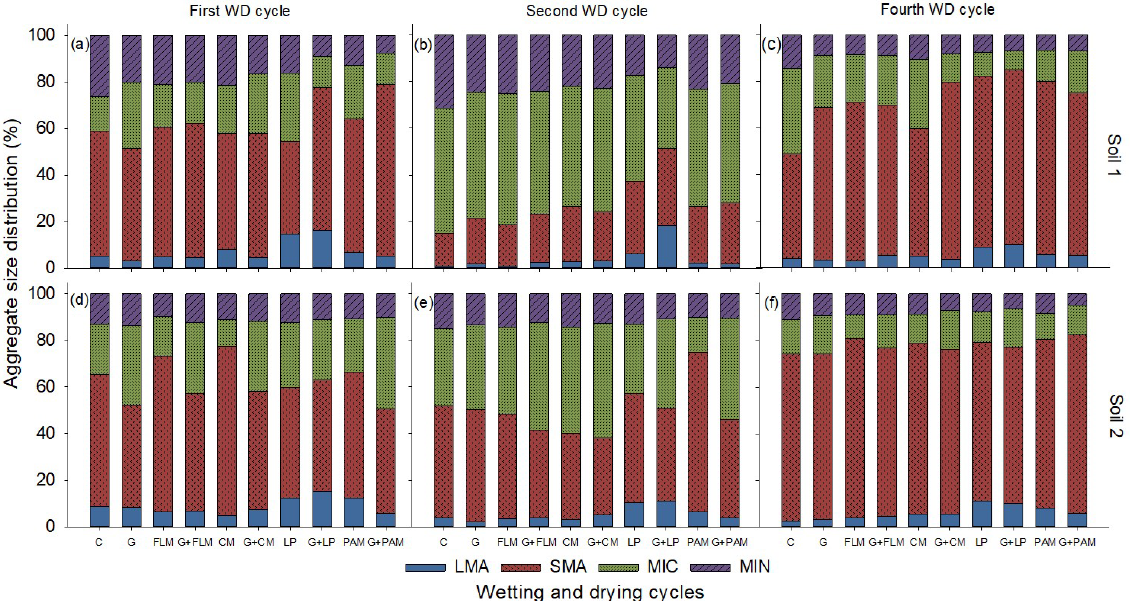
Figure 1. Distribution of the aggregate sizes in the two soils after addition of amendments after first, second, and fourth WD cycles. First WD cycle ( a : Soil 1 and d : Soil 2), second WD cycle ( b : Soil 1 and e : Soil 2), and fourth WD cycle ( c : Soil 1 and f : Soil 2). C: control, G: gypsum, PAM: anionic polyacrylamide, FLM: feedlot manure, CM: chicken manure, and LP: lucerne pellets. Large macroaggregates ( > 2000µm), small macroaggregates (2000–250µm), microaggregates (250–53µm), and silt + clay fraction ( < 53µm). Error bars have been omitted to improve